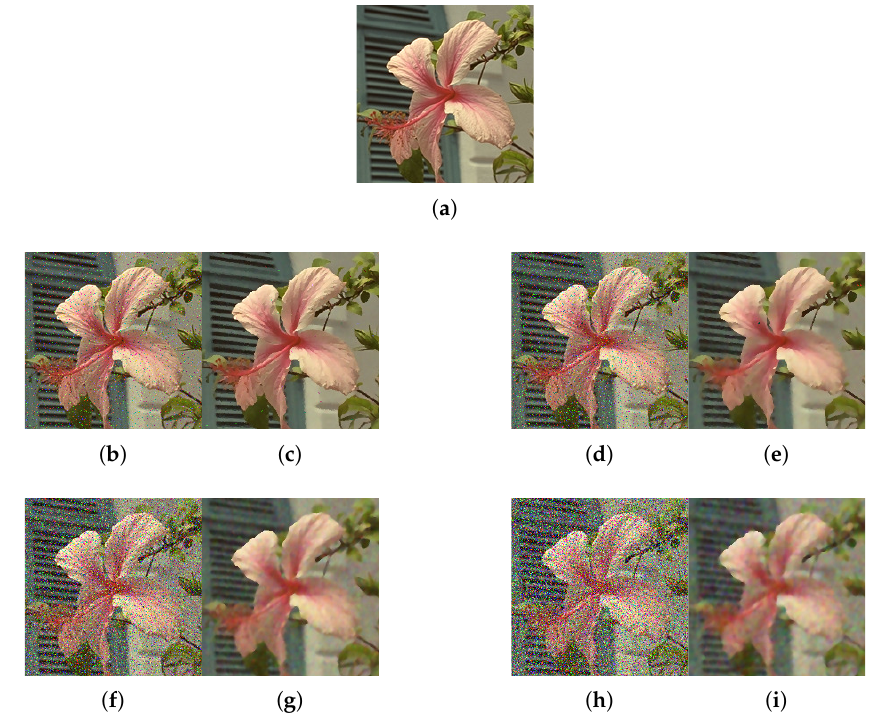
Figure 7. Method outputs. Image Flower contaminated with impulse p and Gaussian noise σ . ( a ) Flower. ( b ) Noisy p = 0.05, σ = 5. ( c ) Filter output. ( d ) Noisy p = 0.1, σ = 10. ( e ) Filter output. ( f ) Noisy p = 0.2, σ = 20. ( g ) Filter output. ( h ) Noisy p = 0.3, σ = 30. ( i ) Filter